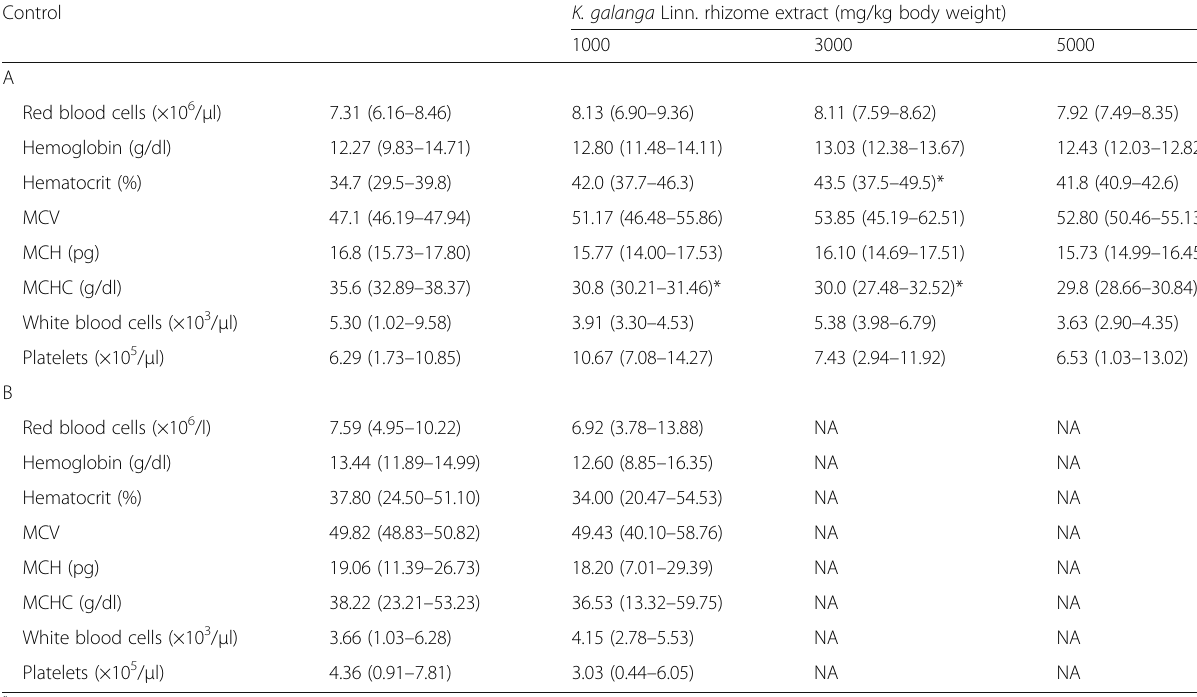
Table 1 Haematological profiles of (A) male and (B) female mice at the end of subacute toxicity dosing of K. galanga Linn. rhizome extract (1000, 3000, and 5000 mg/kg body weight) and untreated control mice. Data are presented as median (95%